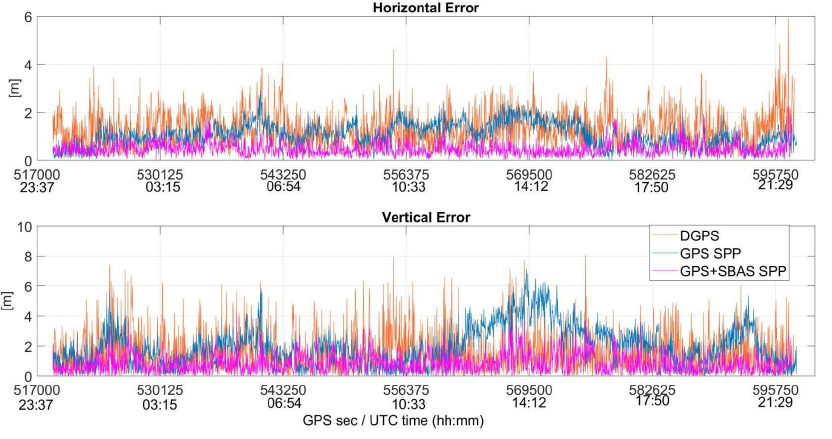
Figure 10. Horizontal and vertical positioning errors (in meters) as function of the time for GPS SPP (blue line), GPS + SBAS SPP (magenta line) and DGPS (orange line)